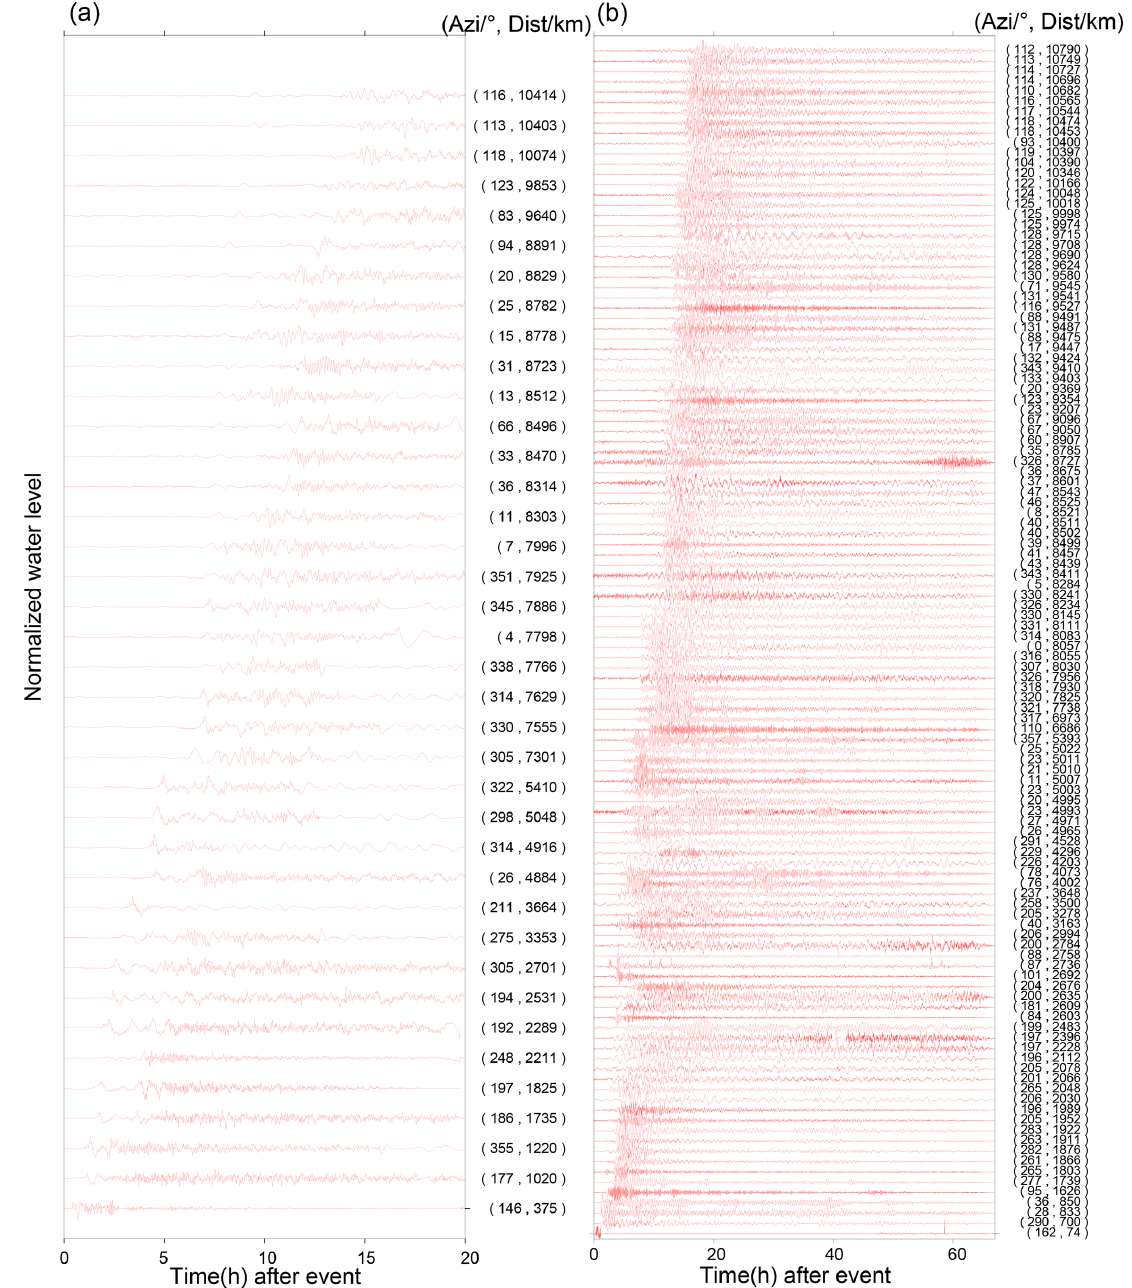
Figure 2. Detided tsunami waveforms at (a) DART buoys and (b) tide gauges. Waveforms in both subplots are shown in ascending distance. Azi stands for azimuth. The data are normalized with respect to the largest amplitude of each tide gauge.